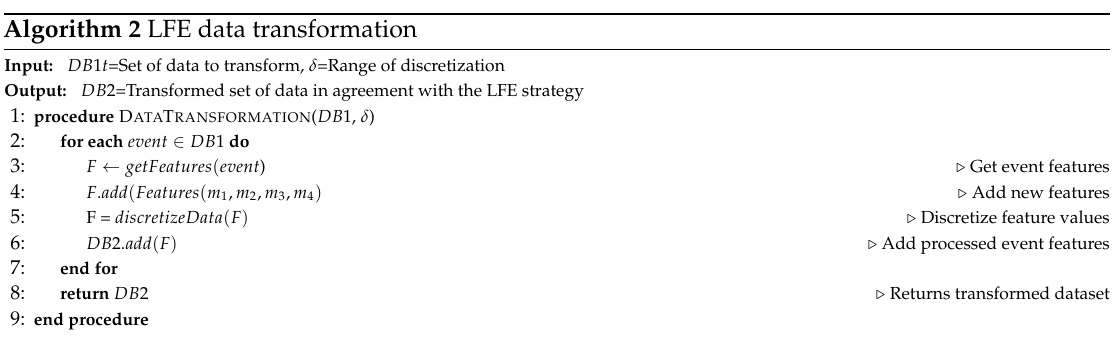
Algorithm 2 LFE data transformation